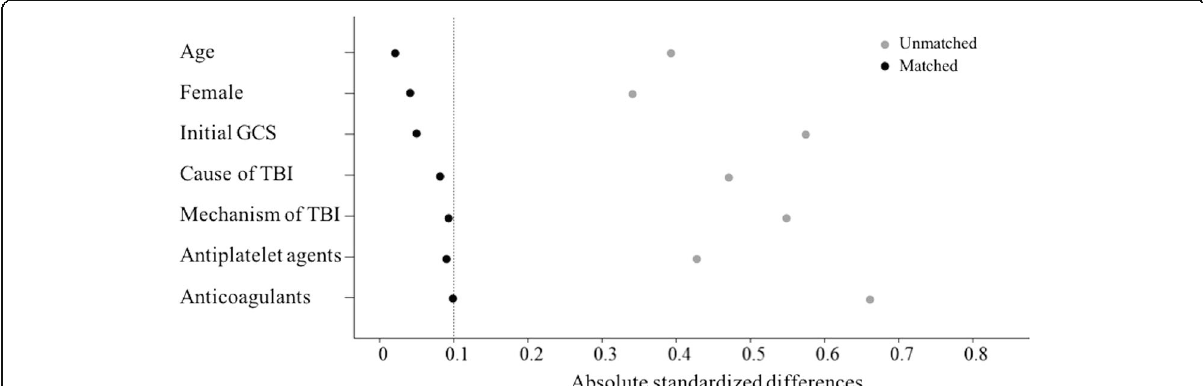
Fig. 1 Absolute standardized difference (ASD) before and after propensity score matching. ASD < 0.10 implies good balance between the two groups. GCS, Glasgow Coma Scale; TBI, traumatic brain